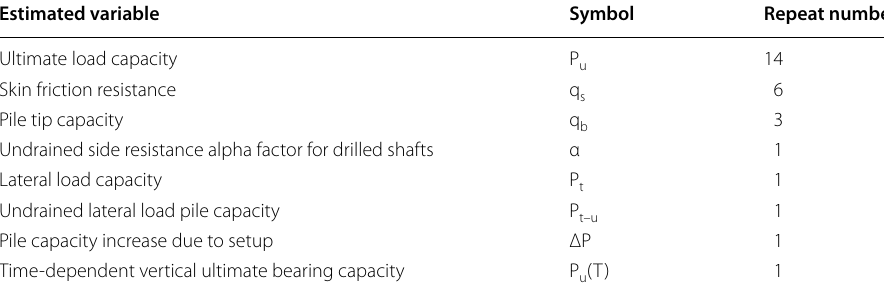
Table 6 ANN estimated variables Estimated variable Symbol Repeat